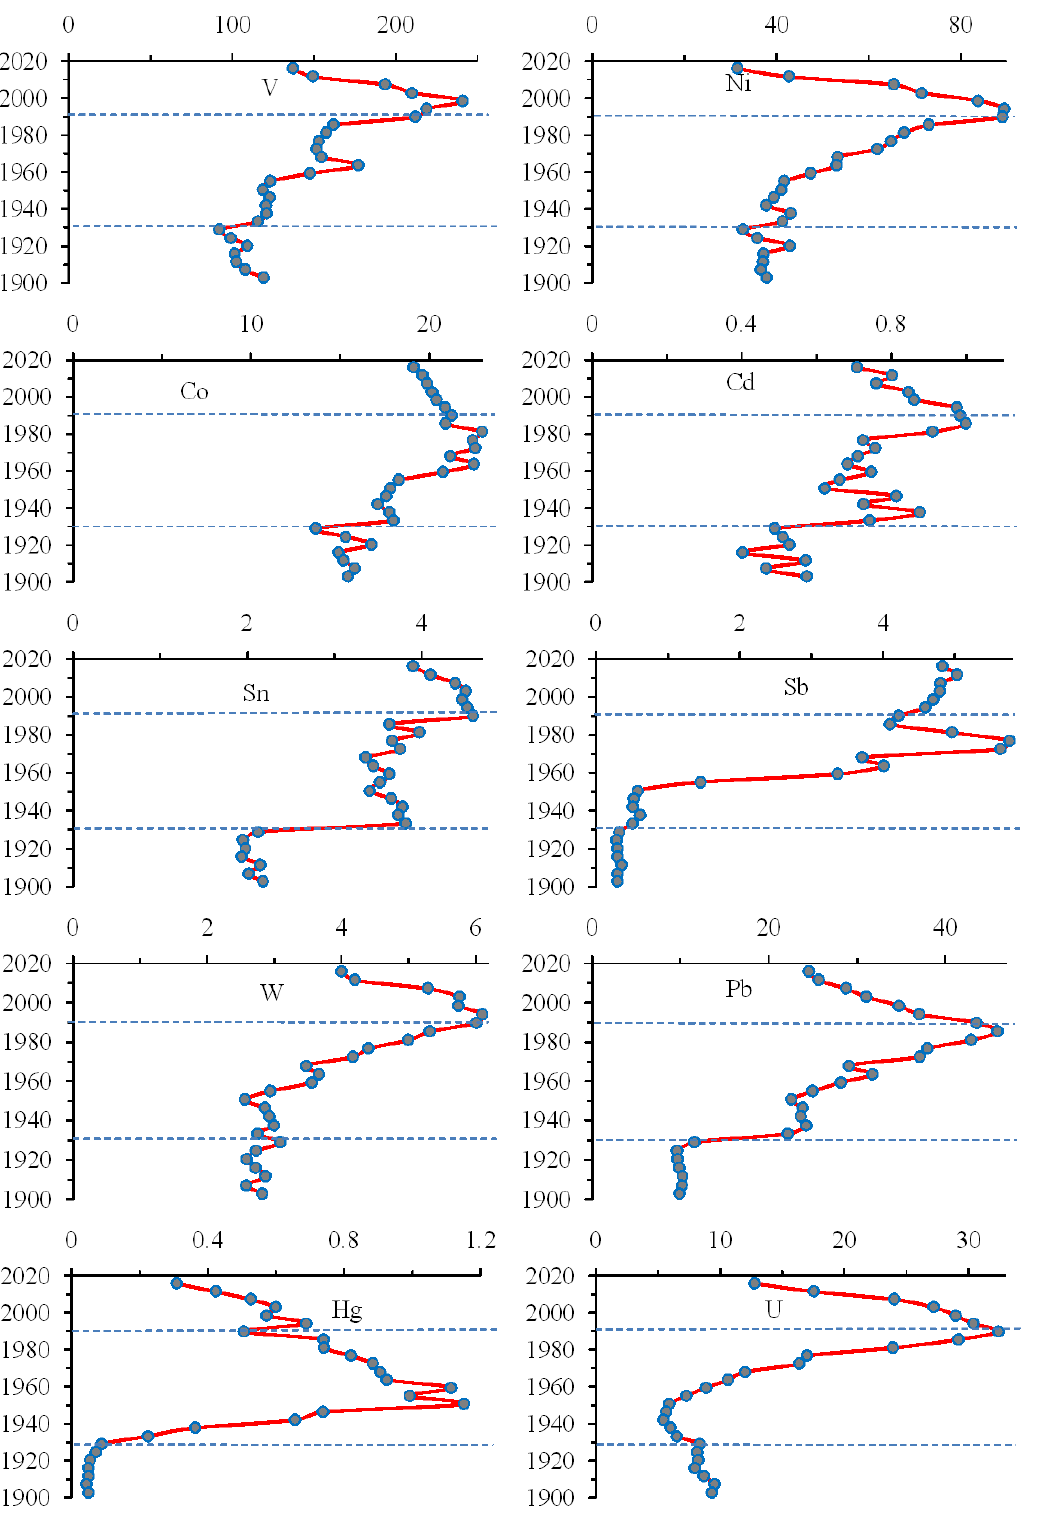
Figure 10. Vertical distribution of the content of elements (µg/g) that reduce the content in the upper sediment layers of Lake Bolshoy Vudjavr.